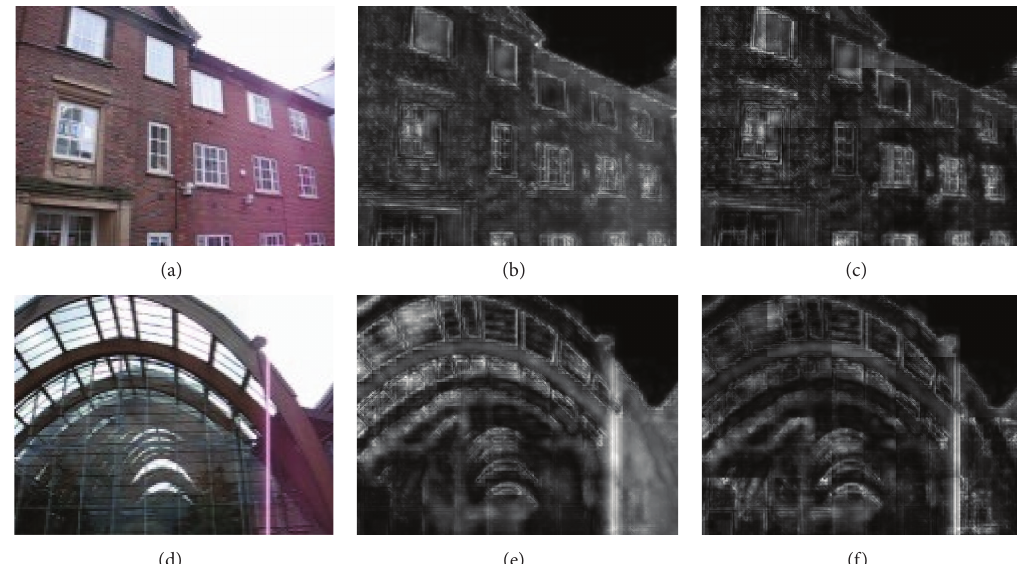
Figure 2: The effect of nonuniform illumination on saliency. (a) and (d) are the original maps selected from the Sheffield buildings database. (b) and (e) are saliency maps calculated by Itti’s model. (c) and (f) are subregions based saliency maps.